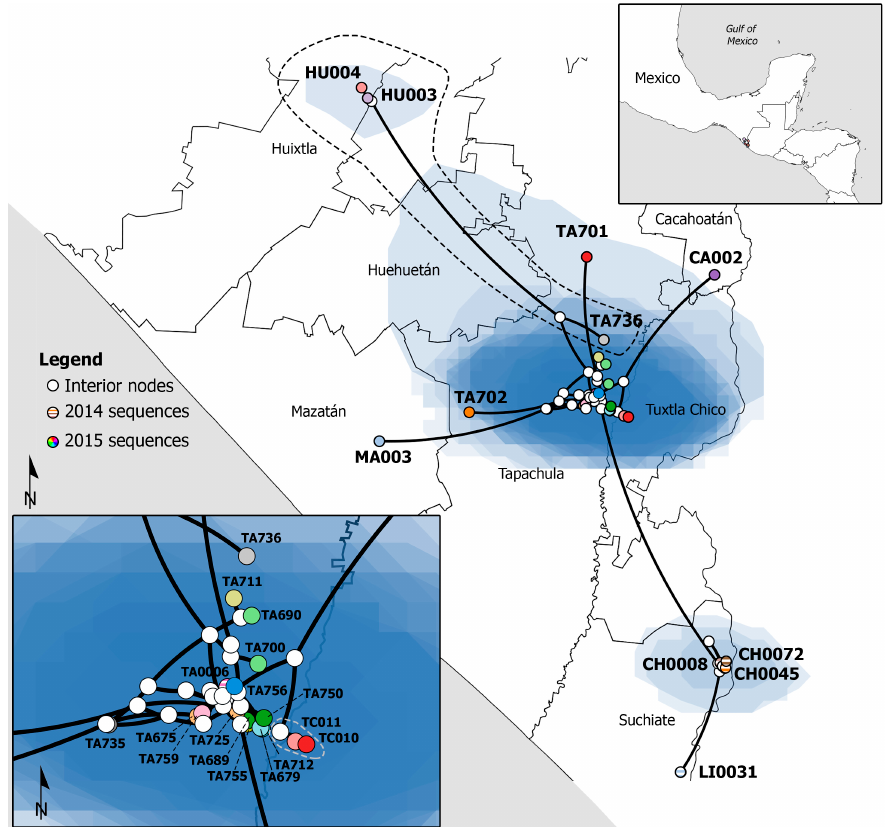
Figure 2. Spatiotemporal epidemic history of CHIKV in Southern Chiapas. White circles represent interior nodes, while colored circles represent the analyzed sequences. Circles with horizontal lines correspond to sequences from 2014. Circles with solid colors correspond to sequences from 2015. The blue polygons represent the 80% HPD of the location. The black dashed lined shows the Huixtla clade. The gray dashed line shows the Tuxtla Chico clade. The upper right square shows the location of Southern Chiapas. The lower left square is a magnification of the sequences from Tapachula and Tuxtla Chico. The outbreak started in Ciudad Hidalgo and spread upwards to Tapachula.